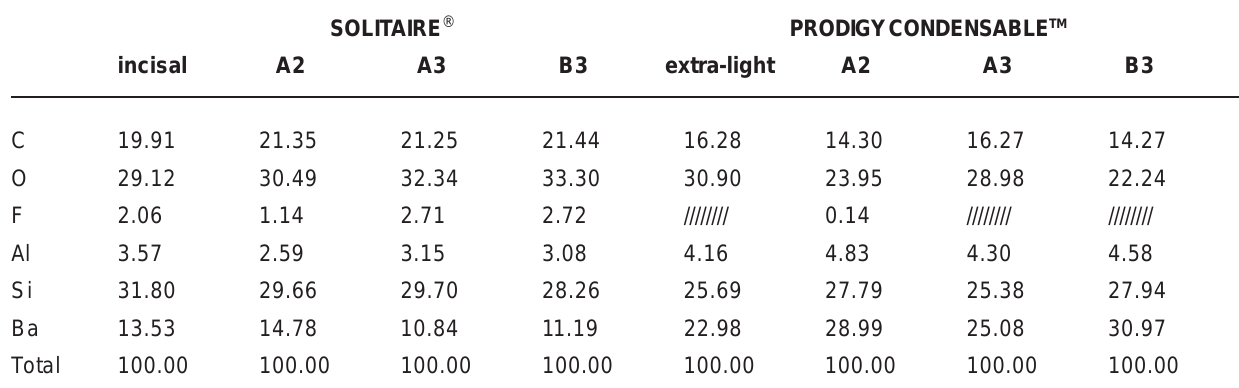
TABLE 1- Weight percentage of the components of the resins tested: carbon (C), oxygen (O), fluorine (F), aluminum (Al), silica (Si) and barium